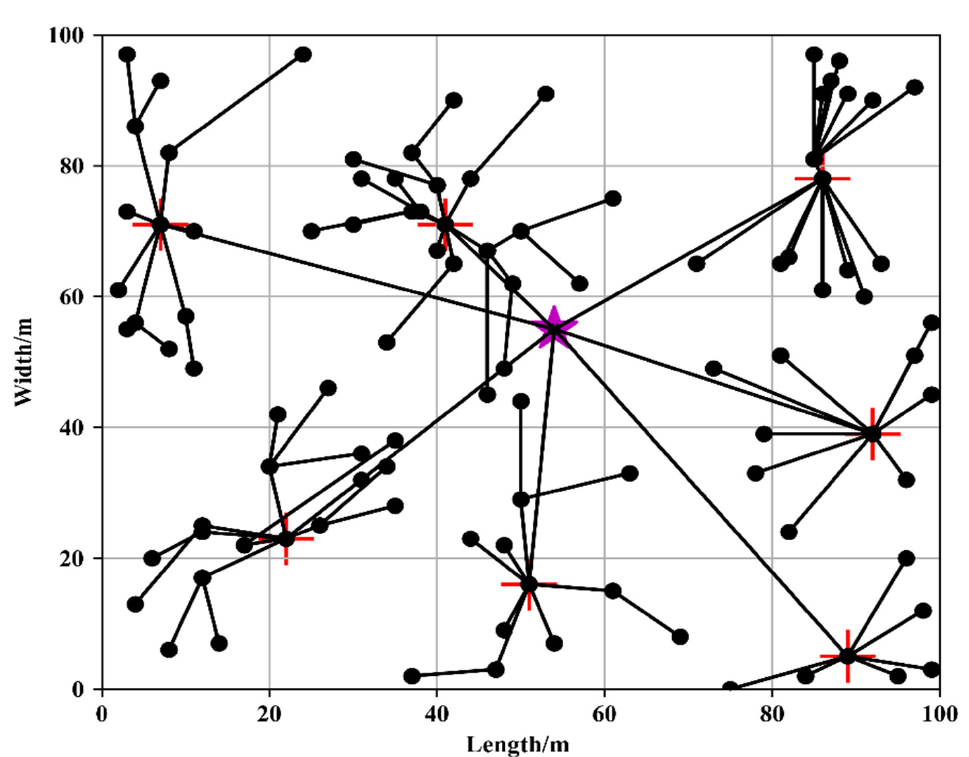
Figure 7. Optimal base station location using CECGA for 100 nodes with center (54,55).